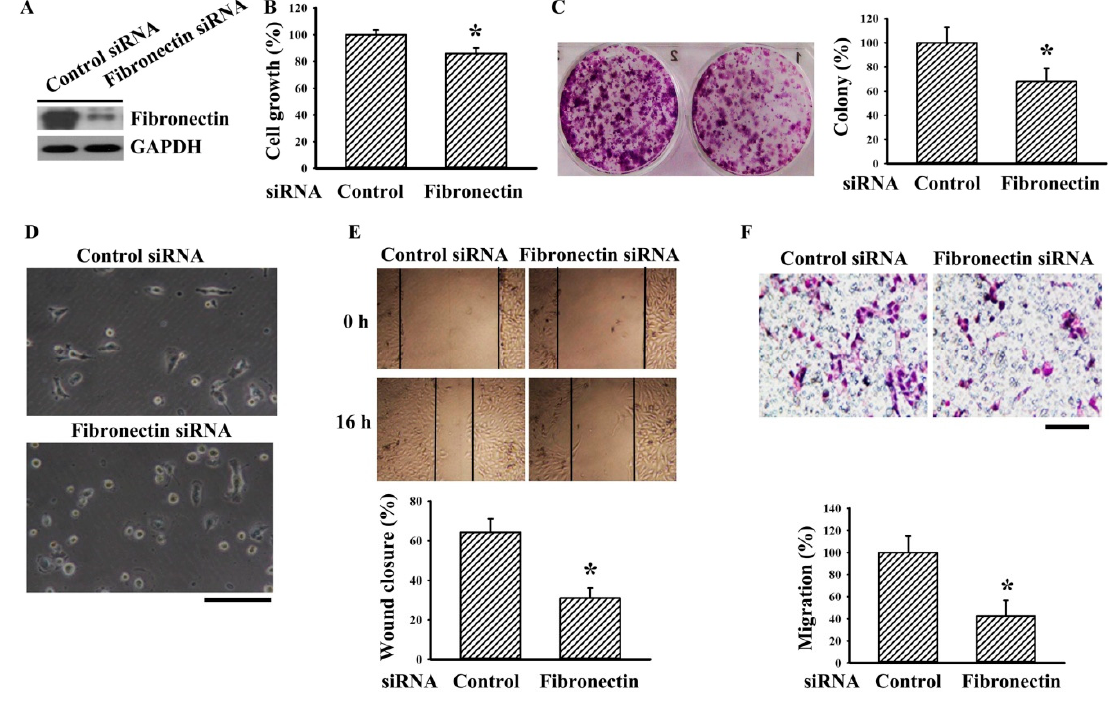
Figure 1. Fibronectin silencing decreased cell growth and migration in 786-O cells. 786-O cells were transfected with control siRNA and fibronectin siRNA for 48 h. ( A ) Proteins were extracted and subjected to Western blot analysis with indicated antibodies. Representative blots are shown. ( B ) The resultant transfected cells were seeded onto 96-well plates. Twenty-four hours later, cell growth was measured by MTS reduction assay. ( C ) The resultant transfected cells were seeded onto six-well plates for seven days. Cell colonies were fixed and stained with crystal violet. Representative plates are shown. The numbers of cell colonies were calculated and depicted. ( D ) The resultant transfected cells were seeded onto six-well plates for 1 h. Cells were examined under a light microscope. Representative photomicrographs are shown. Scale bar = 50 µ m. ( E ) The resultant transfected cells were seeded onto six-well plates for 24 h. When confluence was reached, cell movement was evaluated by a wound-healing assay for 16 h in the presence of 0.5% FBS. Representative photomicrographs are shown. Bar graphs show relative wound closure among groups. ( F ) The resultant transfected cells were seeded onto Transwell inserts and subjected to Transwell migration assay for 24 h. The lower chambers were filled with DMEM containing 10% FBS. Representative photomicrographs are shown. Scale bar = 50 µ m. Bar graphs show quantitative results among groups and the value in the control siRNA group was defined as 100% ( B , C , and F ). * p < 0.05 vs. control siRNA group, n = 3.